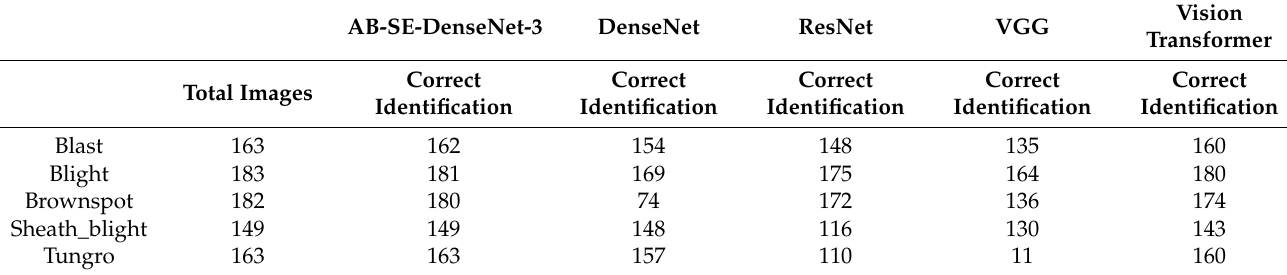
Table 4. Comparison of statistical results of different models.